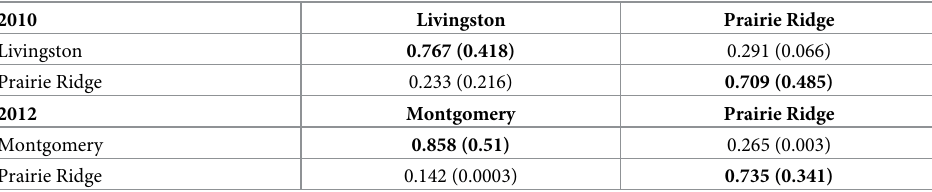
Table 3. Rates of migration versus residency for M . ochrogaster .